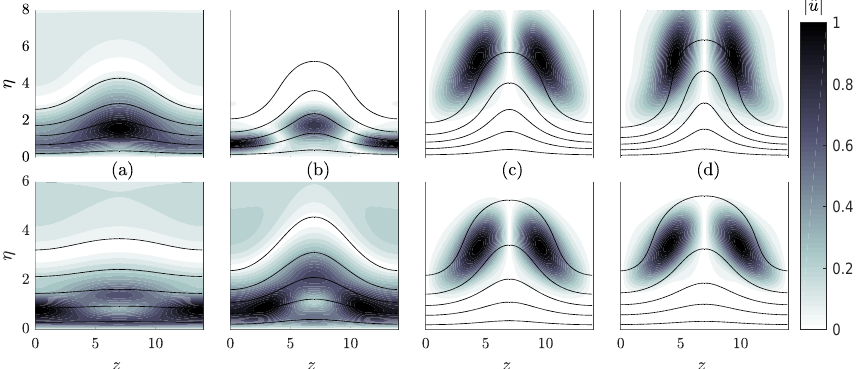
= 0.14 ( a ), 0.25 ( b ), max